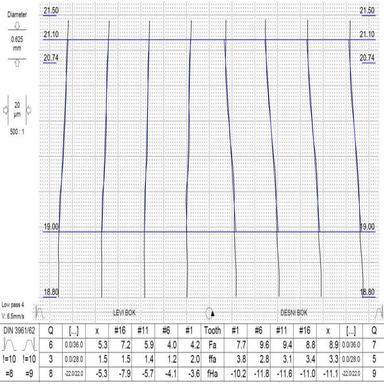
Standardised flank measurement of the POM gear on CMM.